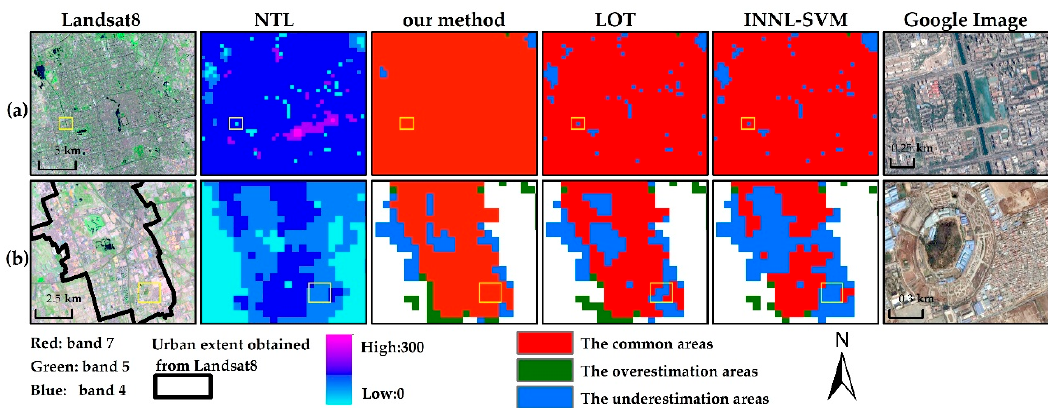
Figure 9. Spatial Comparison of the results different methods for Beijing: ( a ) the inner part of urban; ( b ) the edge district of urban; the yellow box is the area zooming in of the google image.